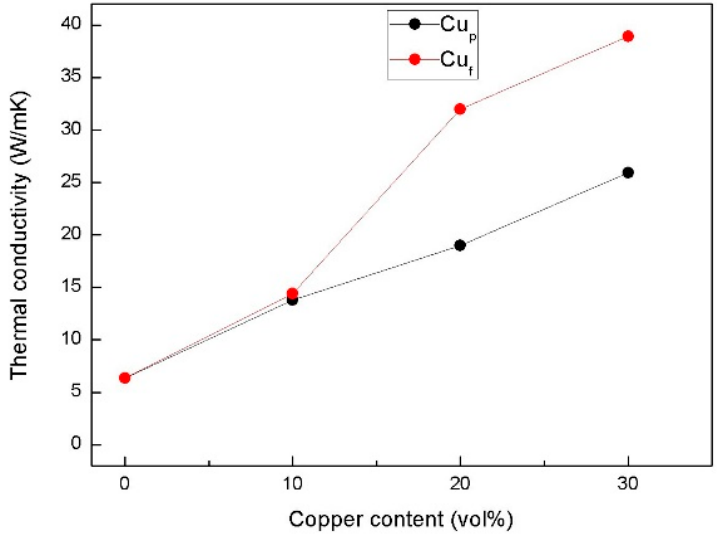
Figure 10. Thermal conductivity of Al 2 O 3 /30glass/Cu as a function of Cu content.